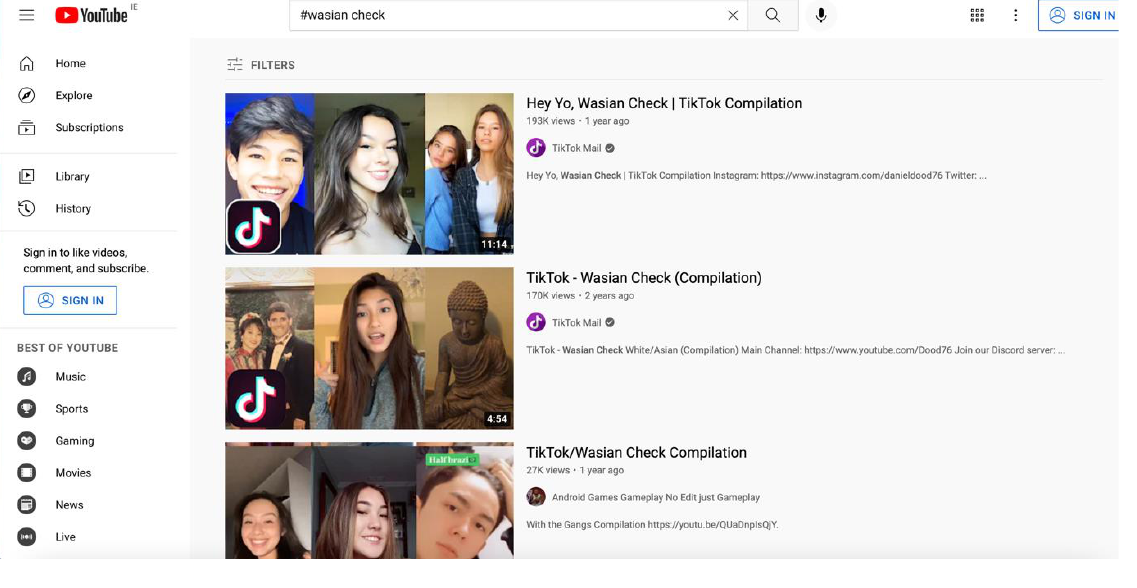
Figure 2. #Wasian Check Compilation Videos (https://www.youtube.com/watch?v=XAei7WFbzhs, accessed on 6 June 2022).